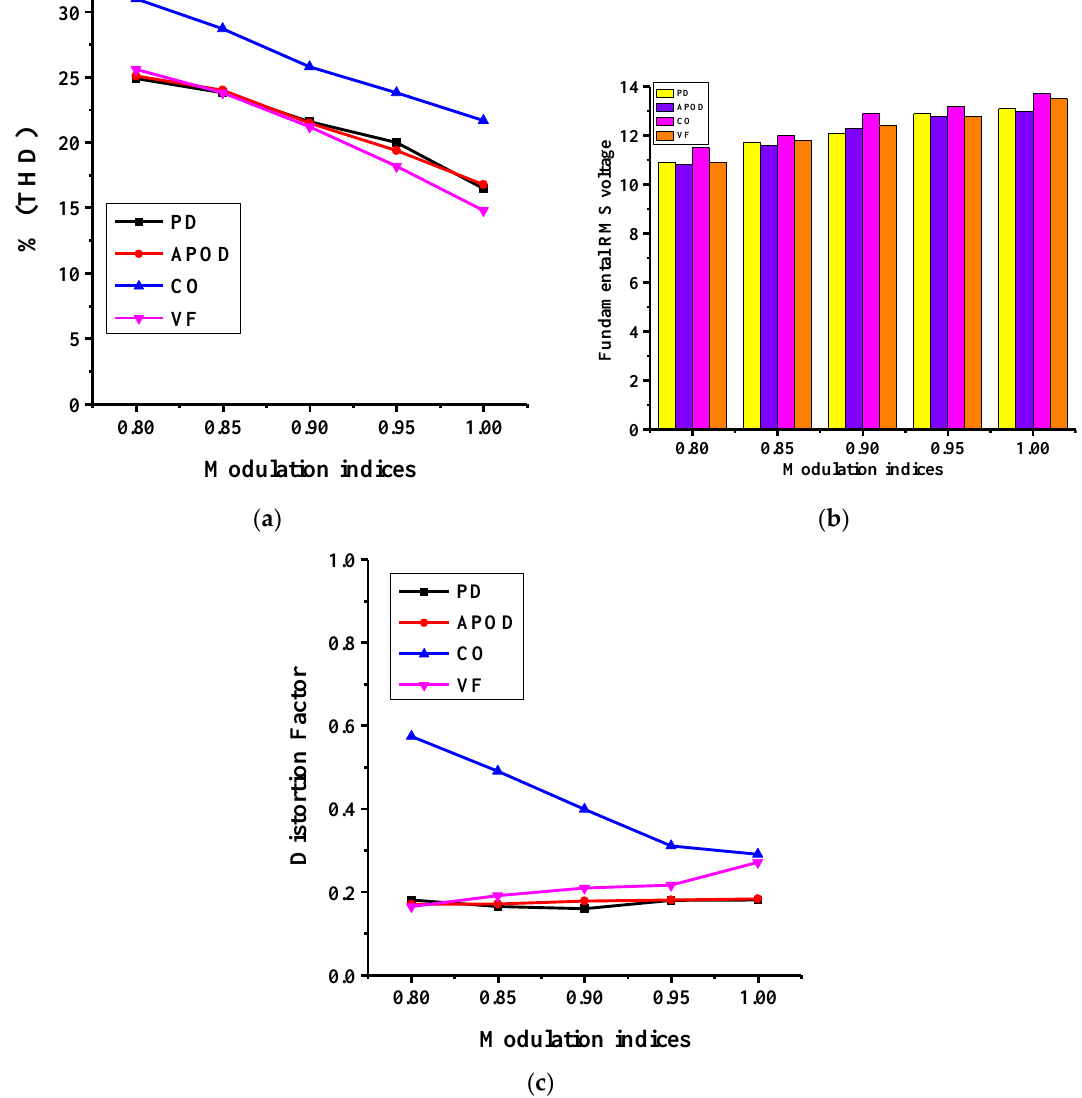
Figure 21. Different parameters for different modulation indices using experimental results: ( a ) %THD; ( b ) V RMS ; ( c ) %DF .